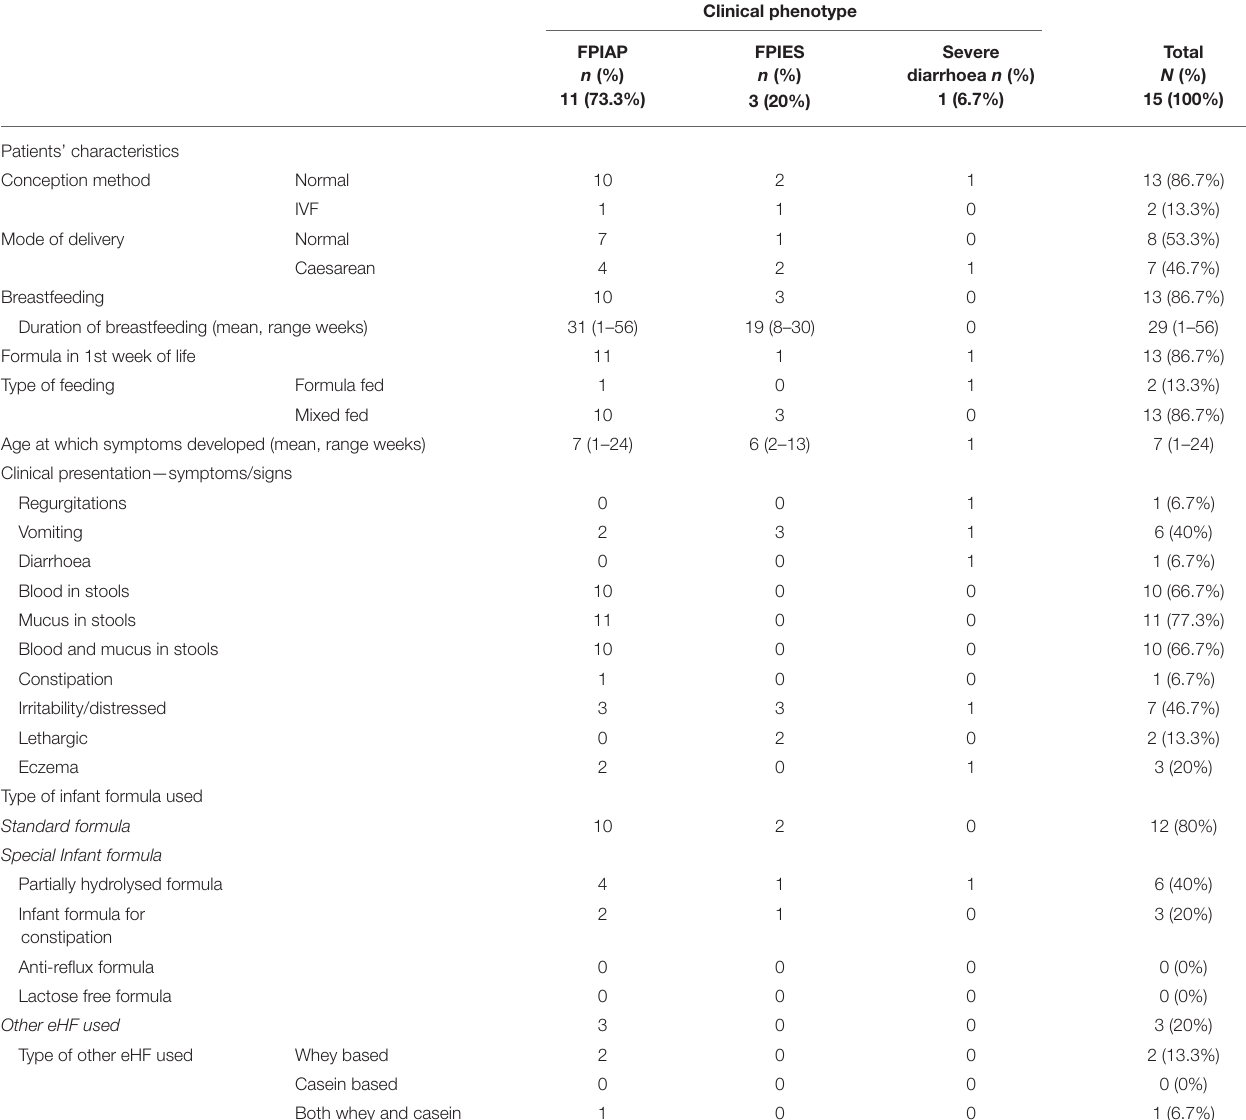
TABLE 1 | Characteristics of patients with CMPA by Clinical Phenotype at time of